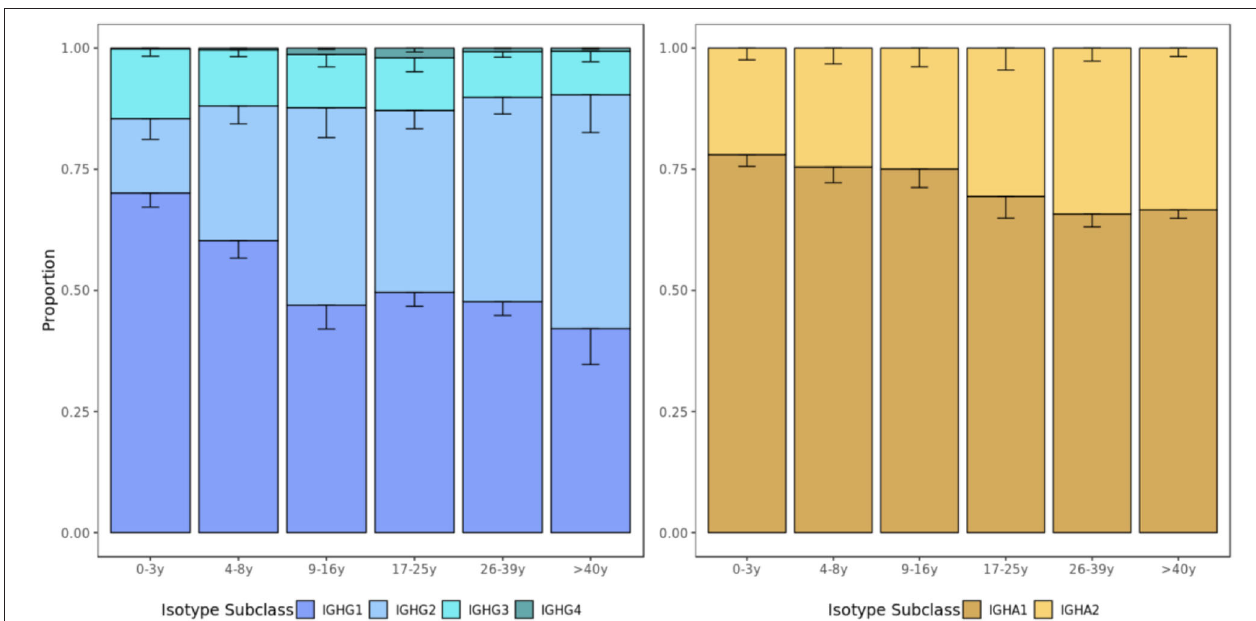
FIGURE 6 | Usage of IgG and IgA subclasses by age group. The IgG and IgA isotype subclass usage changes with age. Error bars represent standard error of the mean.